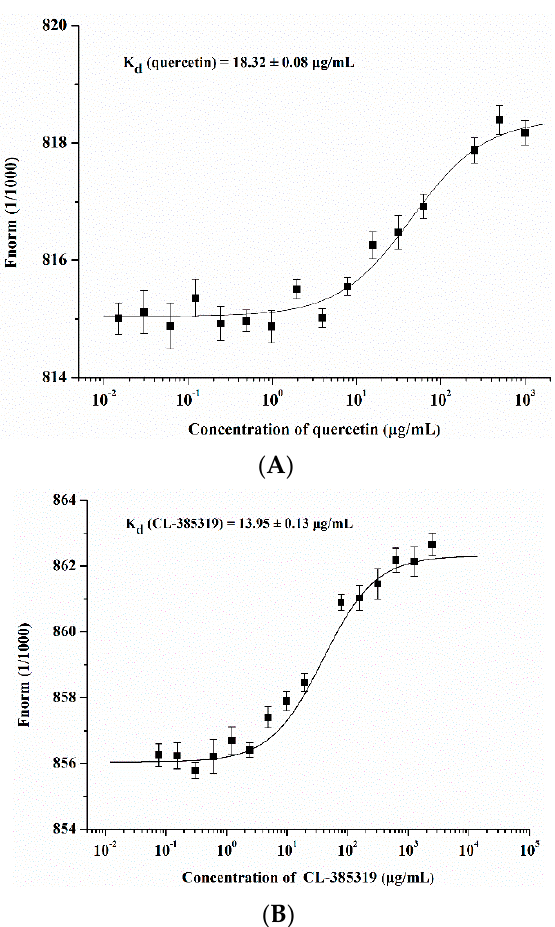
Figure 5. Protein-binding assays in biological liquids using microscale thermophoresis (MST). ( A ) The binding curve of quercetin with NT647 labeled recombinant influenza HA protein; ( B ) The binding curve of CL-385319 with NT647 labeled recombinant influenza HA protein. NT647 (NanoTemper Technologies) labeled recombinant influenza HA protein was mixed with two-fold diluted compounds in the same volume as that of the final concentrations. MST experiments were performed on a Monolith NT.115 system (NanoTemper Technologies) using 100% LED and 20% IR-laser power. The compound CL-385319 was used as the positive control. K d means the dissociation constant.